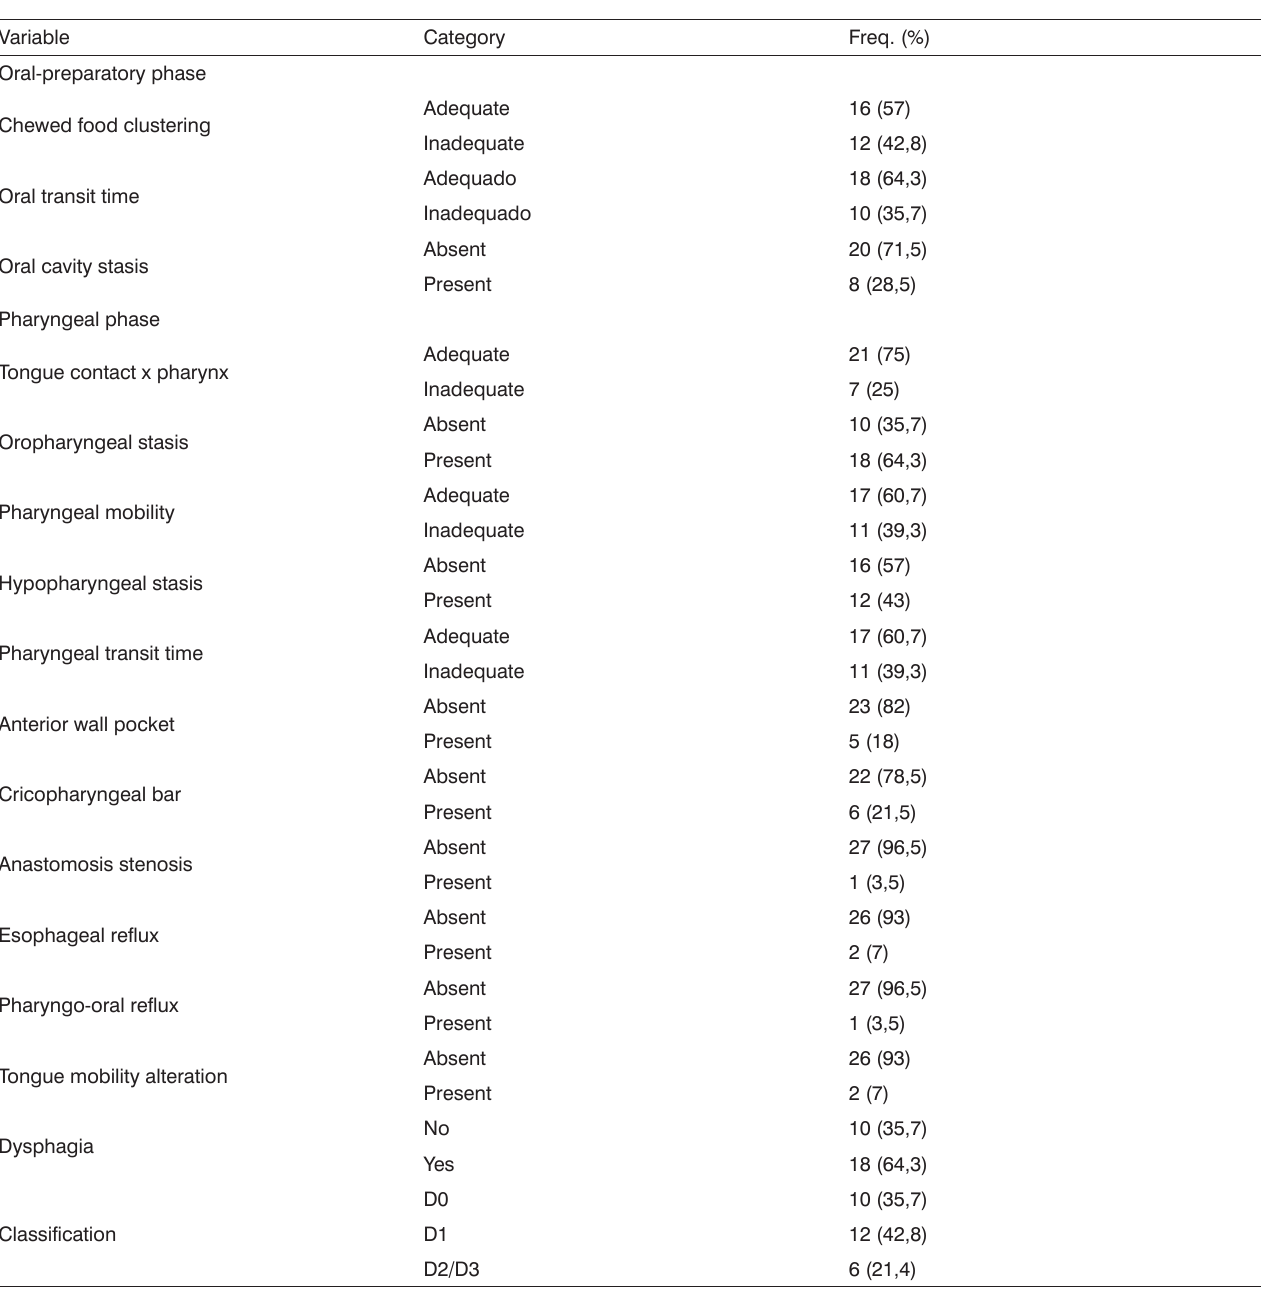
Table 2. Videofluoroscopic evaluation of swallowing. (n=28) Variable